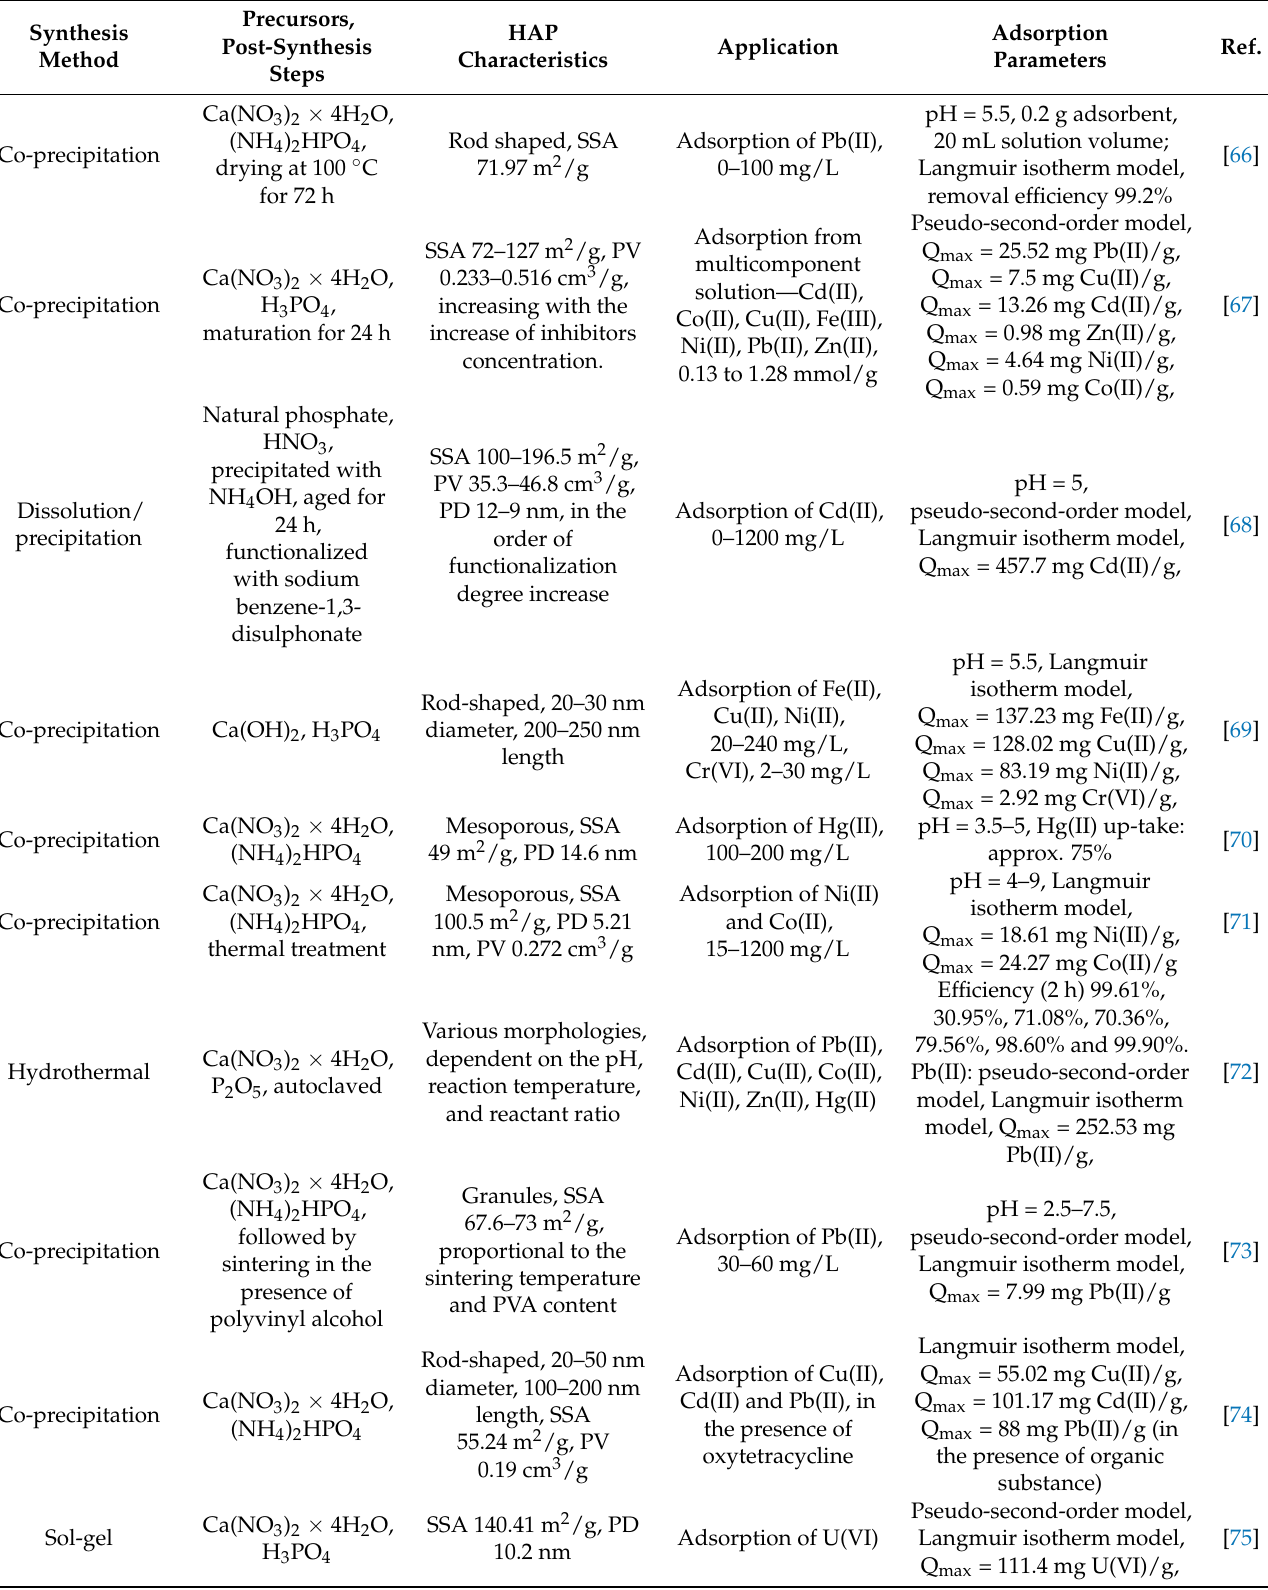
Table 4. Synthesized hydroxyapatite applied for the removal of heavy metals (references presented in chronological order) 1